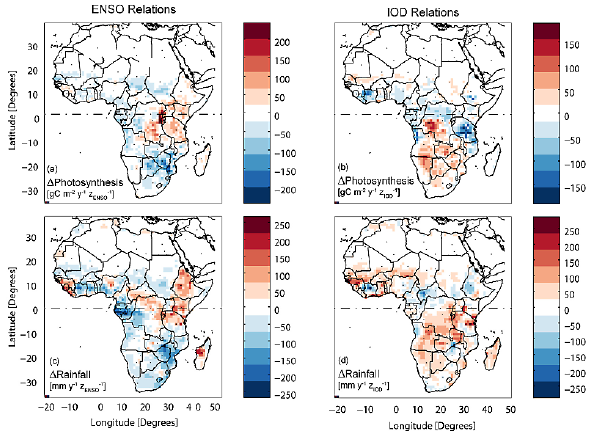
Fig. 6. Standardized interannual variability of gross primary productivity, defined according to Weber et al. (2009) as IAV i modeling exercises. SiB3 results were reported in Williams et al. (2008) and cover the period 1982–2003 and the remaining four were reported in Weber et al. (2009) spanning 1982–2008, reproduced with permission. Values greater than 0 indicate above average interannual variability.